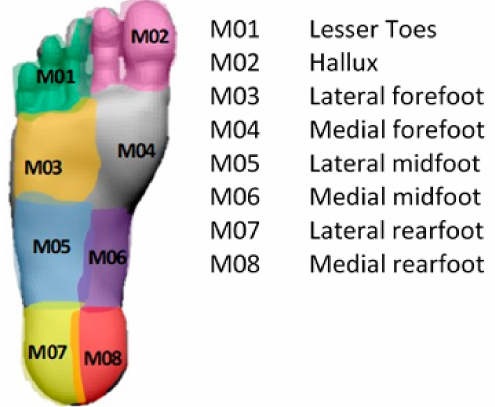
Figure 6. Foot plantar area divided into different